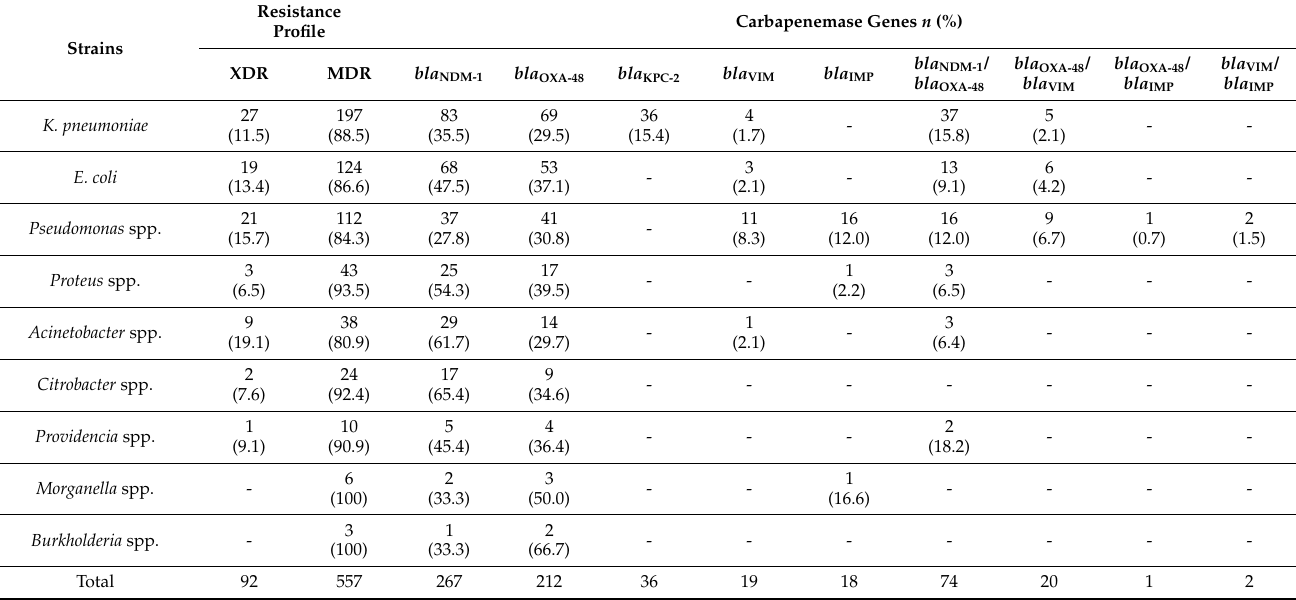
Table 4. Genotypic profile of carbapenem-resistant clinical